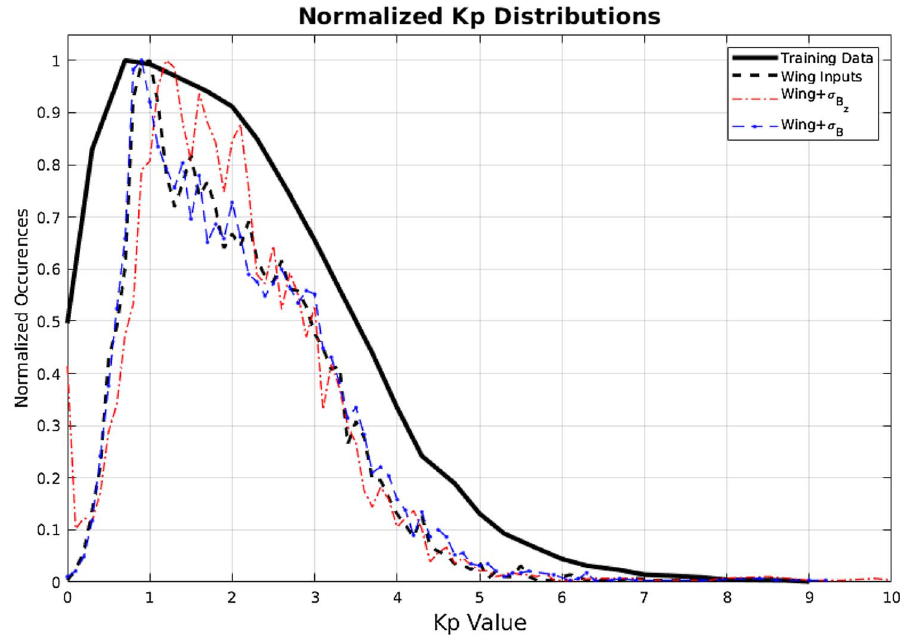
Fig. 7. Frequency of Kp values for full data set 1986 – 2016 and 2017 predictions of three networks trained on the inputs from Wing et al. (2005) with the addition of r B and r B z